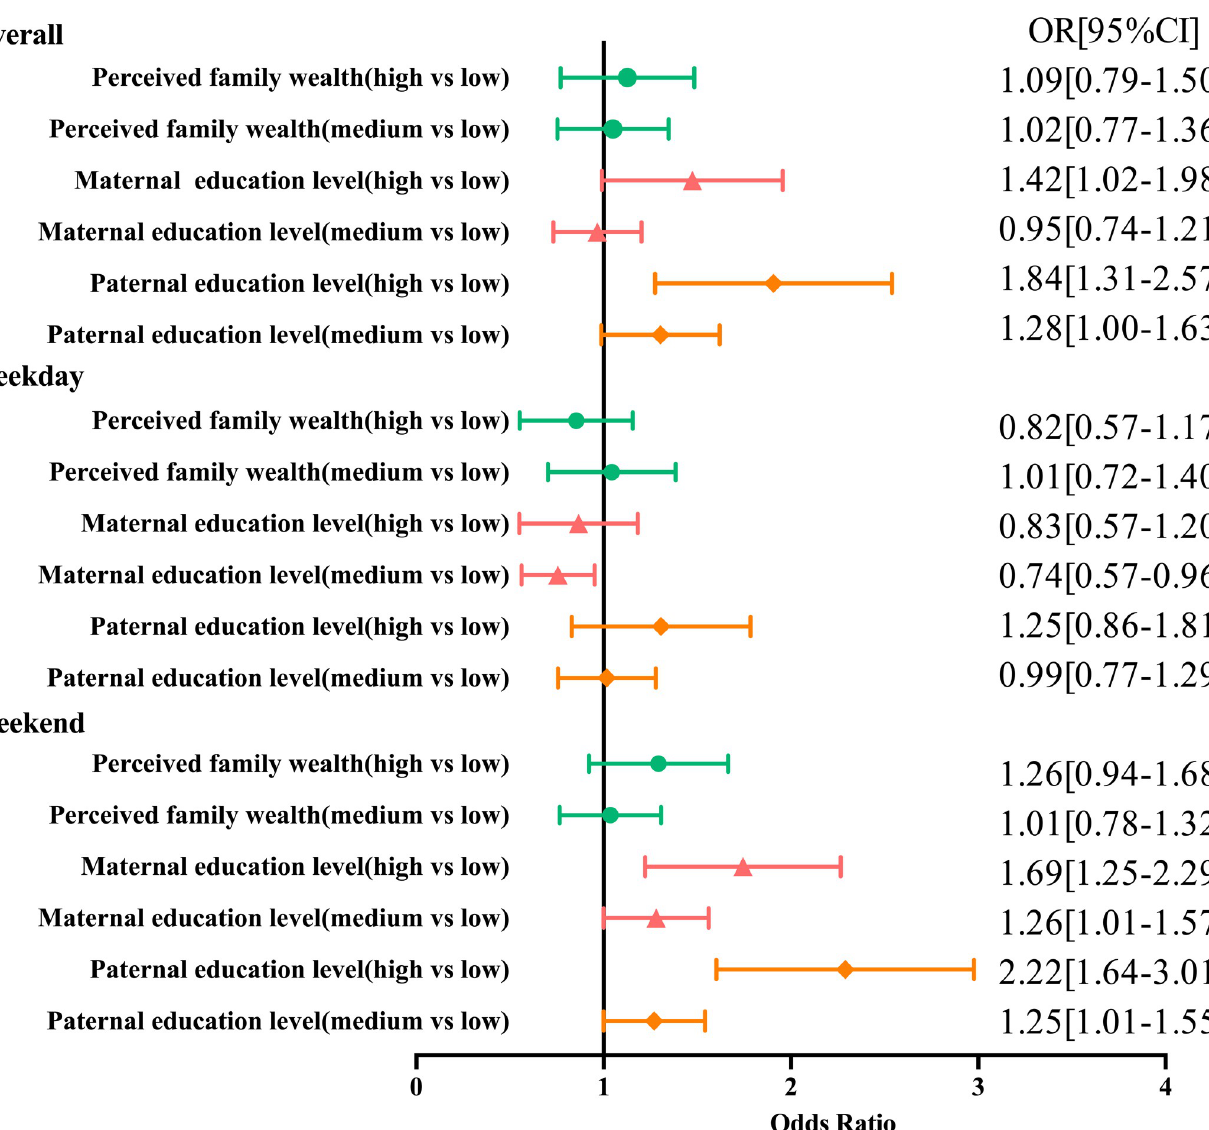
Fig 1. Regression analysis of socioeconomic status and screen